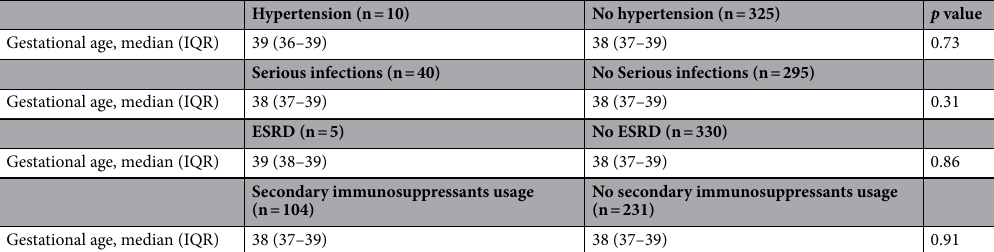
Table 4. Comparison of gestational ages between nephrotic syndrome patients with and without secondary immunosuppressants usage or complications. ESRD End stage of renal